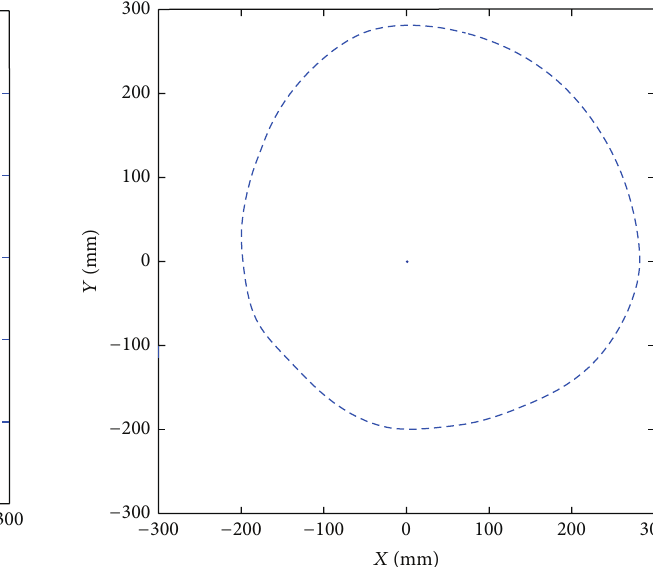
Figure 5: The contour curve of main cam. Figure 6: The contour curve of pair cam.